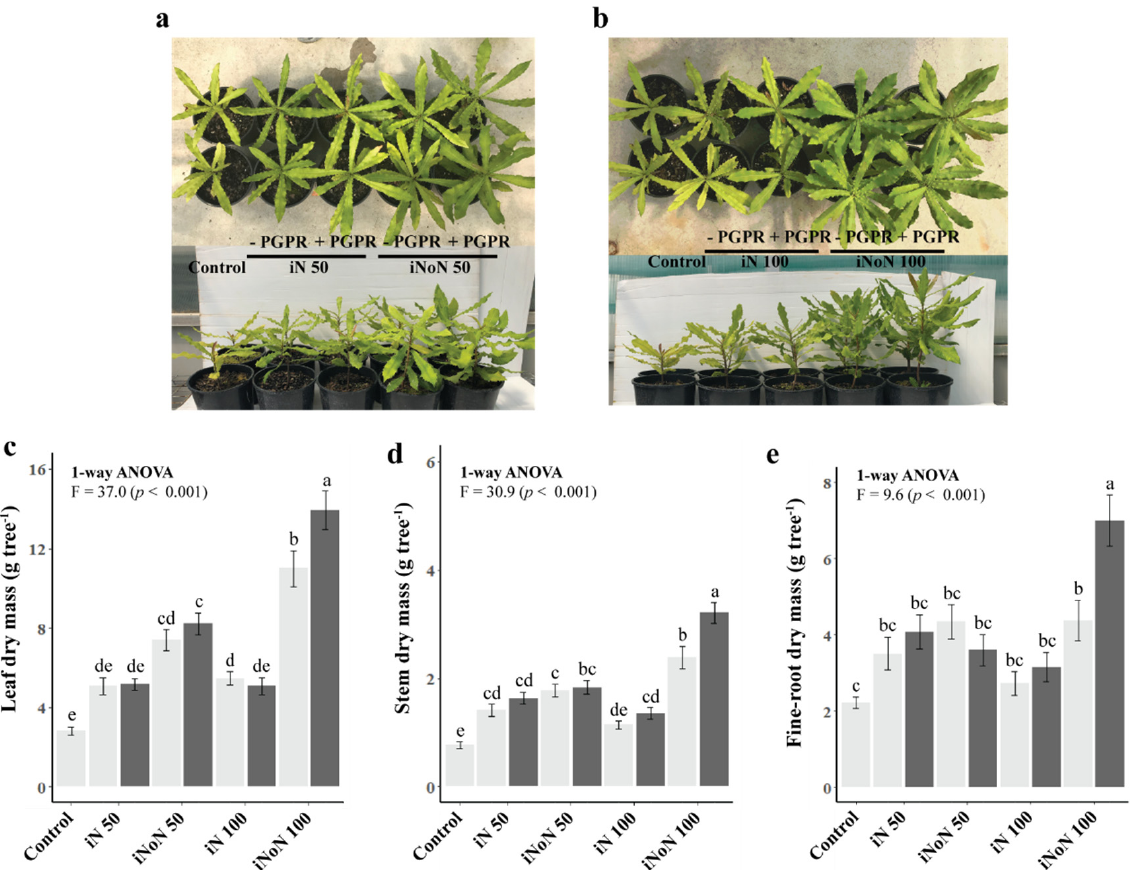
Figure 1. Effects of the plant growth-promoting rhizobacteria (PGPR) on macadamia cultivar 741 seedlings grown under ( a ) low N and ( b ) high N additions of inorganic N fertilizer (iN, 100% urea) or a combined application of inorganic N with poultry manure (iNoN, 50% urea + 50% EcoNPK™) after 28 weeks. Treatment effect on ( c ) leaf, ( d ) stem, ( e ) fine-root dry mass (g tree − 1 ). Control, no N applied other than that present in the potting mix. Light grey bars represent uninoculated treatments; dark grey bars display treatments inoculated with PGPR. Shown are mean absolute dry mass measures ( ± SE, n = 20). Different letters above means indicate significant differences among treatments (one-way ANOVA and Tukey’s post hoc tests, p < 0.05).